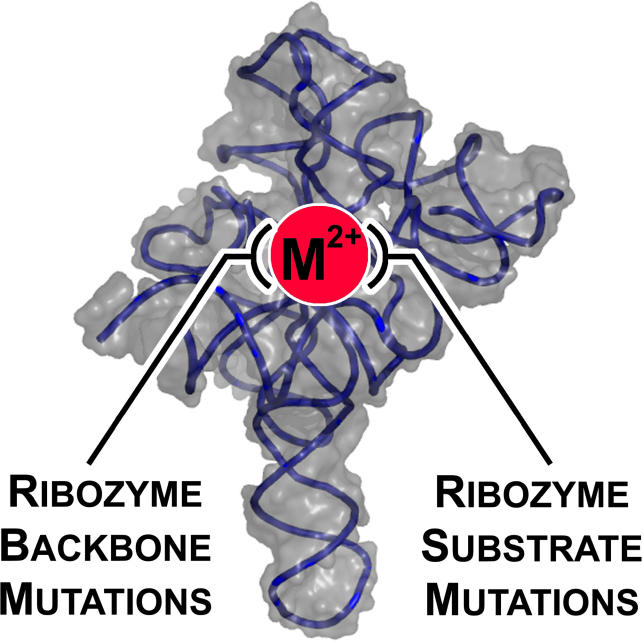
RNA enzymes called ribozymes require metal atoms to function. The site of metal-ribozyme interaction was studied by changing components of both the catalytic center of the ribozyme (the backbone) and its target substrate